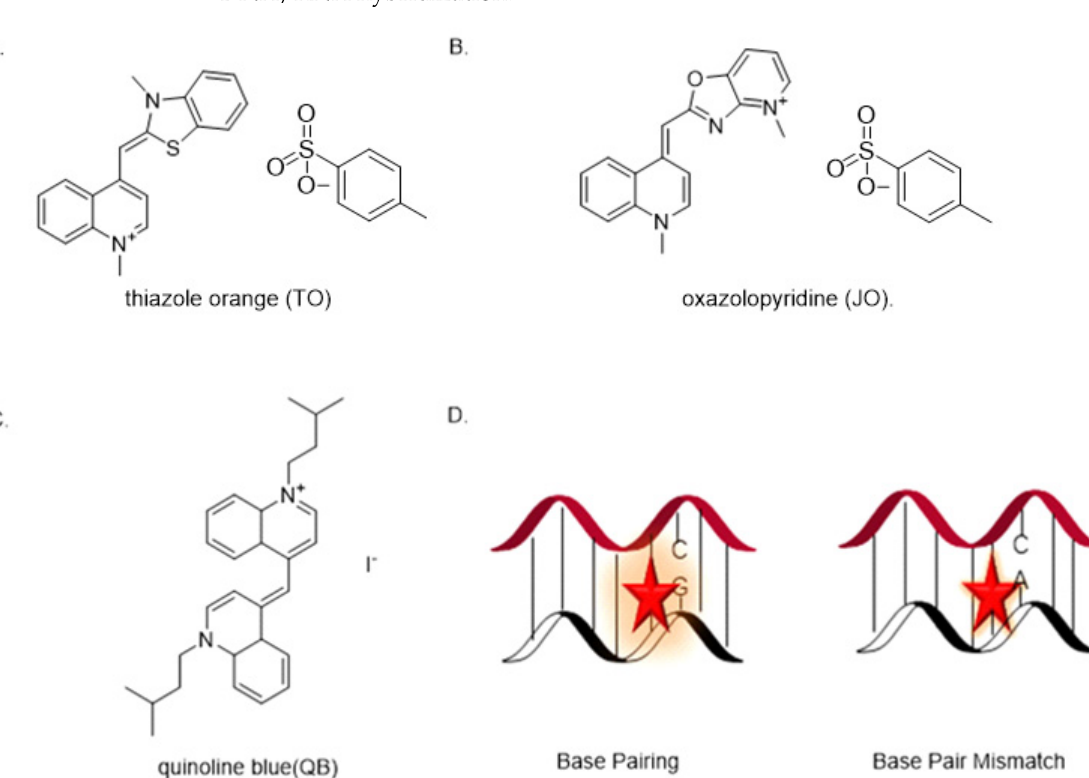
Figure 6. ( A ) Chemical Structure of thiazole orange (TO). ( B ) structure of oxazolopyridine (JO). ( C ) structure of quinoline blue (QB). ( D ) DNA–mRNA match and mismatch; the regular base pairing has far more brightness than the mismatch.